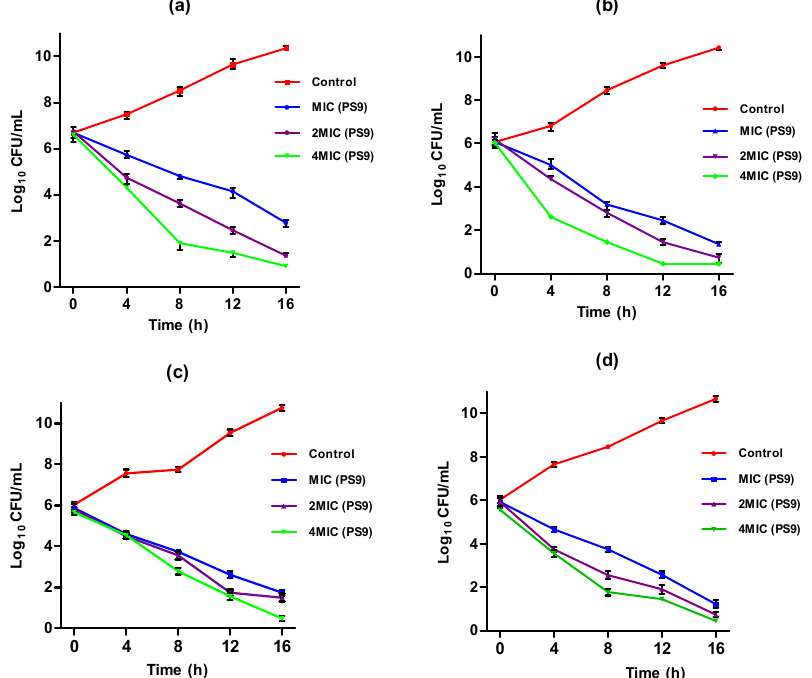
Figure 3. Time-kill curve graph of different bacterial cell supplemented with various concentrations of PS9 ( a ) E. coli , ( b ) P. aeruginosa , ( c ) E. faecalis and ( d ) K. pneumoniae.